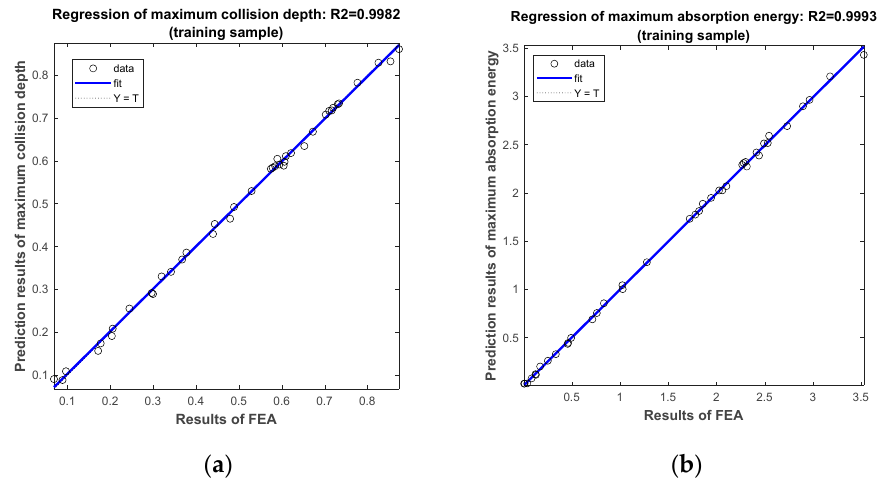
Figure 5. Regression for training samples. ( a ) Regression of maximum collision depth, ( b ) regression of maximum absorption energy.